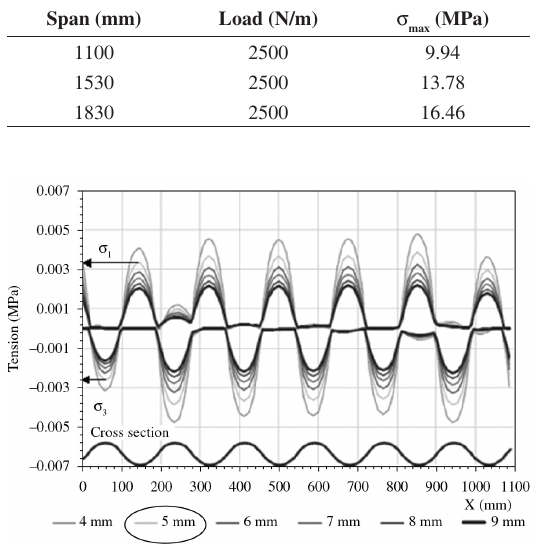
Figure 18. Simulation of the bending test of ABNT NBR 15210-2: Distribution of stresses σ